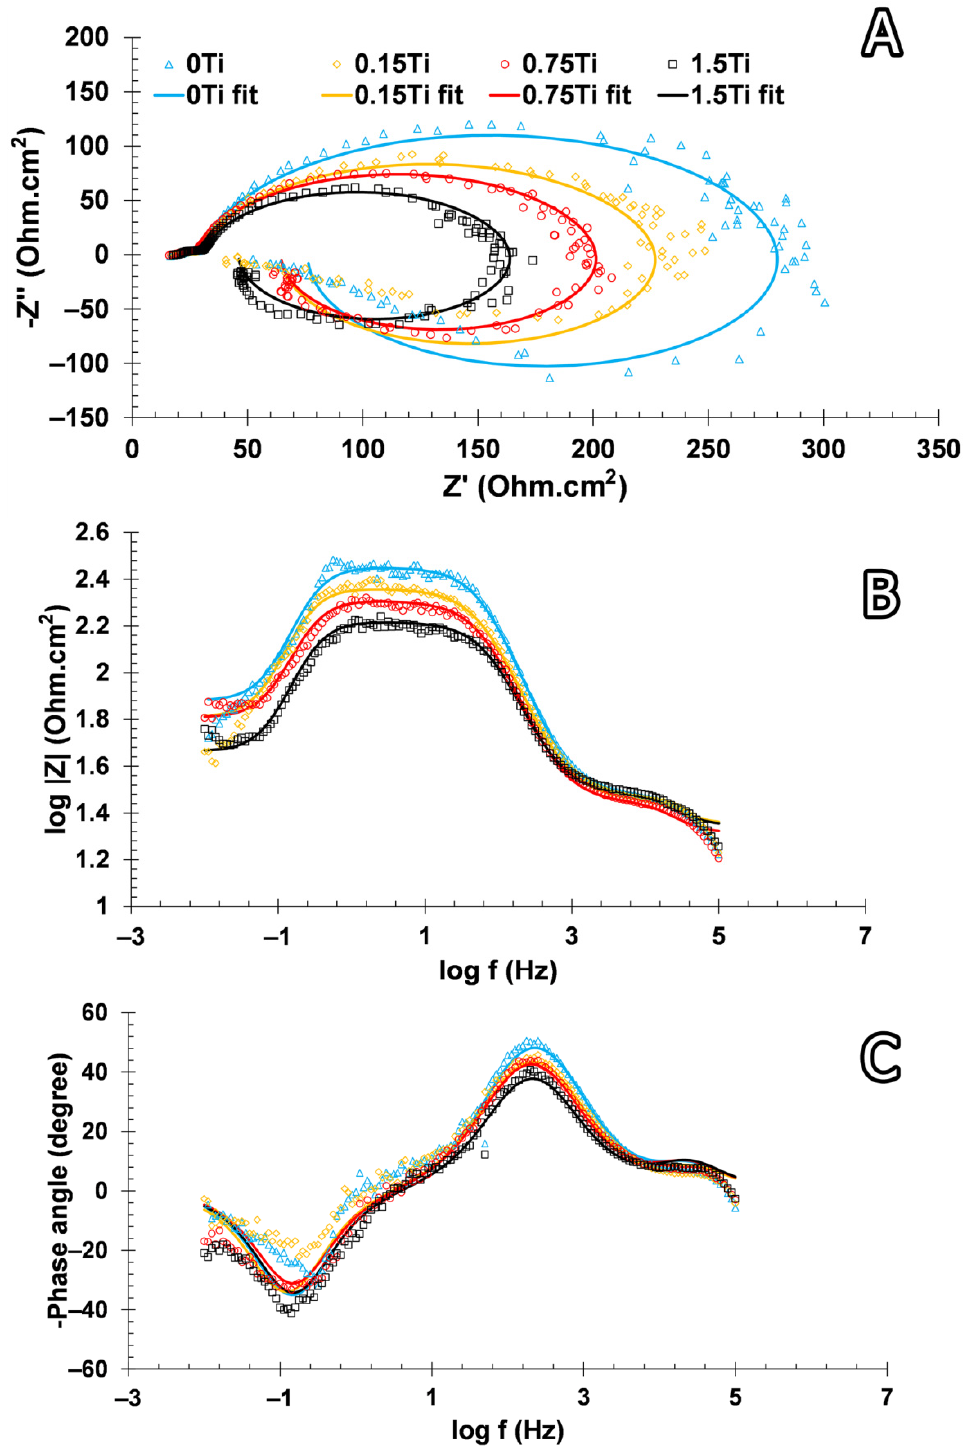
Figure 10. ( A ) Nyquist, ( B ) Bode modulus, and ( C ) Bode-phase angle curves obtained from EIS measurements (markers and solid lines represent the experimental Z observations and the fitted data, respectively).